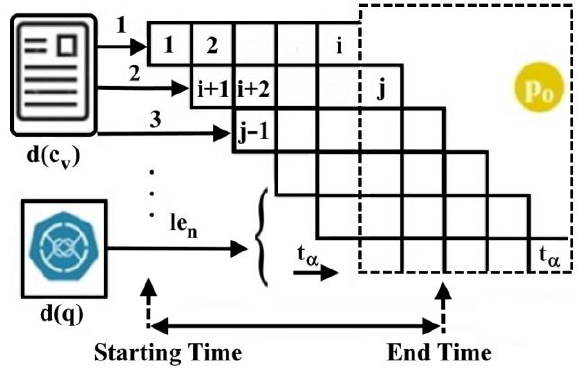
Figure 3. The slot allocation for starting and ending times. The second process is